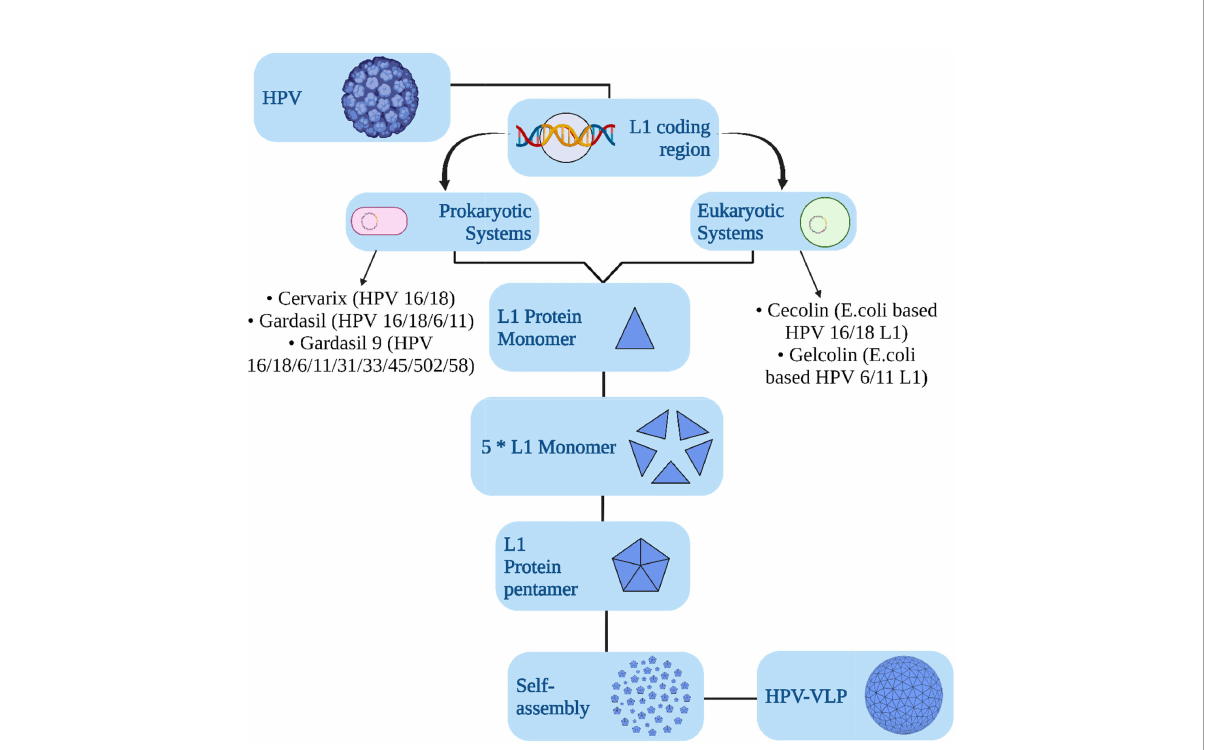
FIGURE 4 Schematic model of the mechanism of action of a prophylactic vaccine (Cervarix, Gardasil, Ceolin, and Gelcolin) used against HPV infection to combat